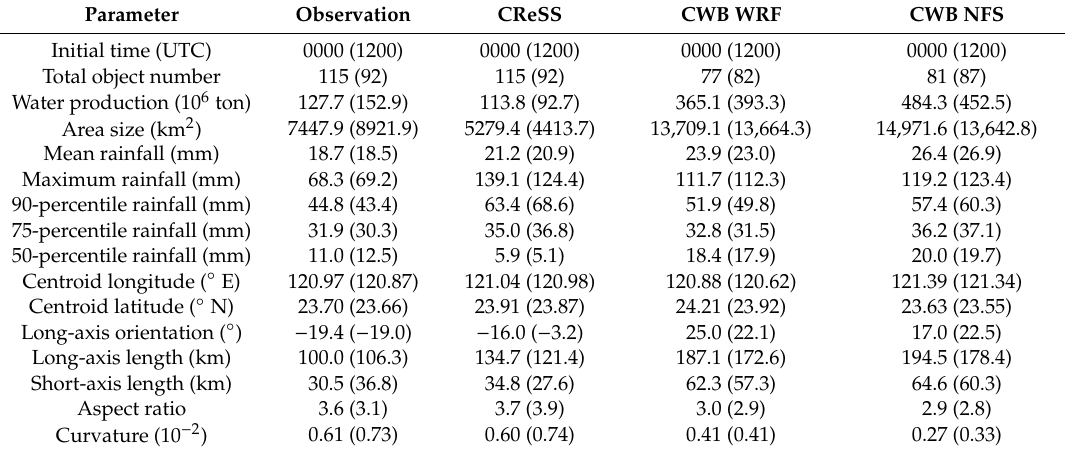
Table 4. Mean value of major parameters and attributes of rainfall objects in observation, and CReSS, CWB WRF, and CWB NFS forecasts initialized at 0000 UTC after matching. The values for 1200-UTC forecasts are also shown (in parentheses). For the initial time of 0000 (1200) UTC, the number of matched objects are 115, 77 and 81 (92, 82 and 87) for CReSS, WRF, and NFS, respectively. For the observation, the values for matched objects with CReSS are